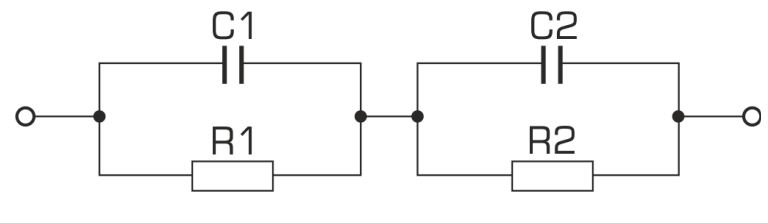
Figure 7. Electric equivalent RC system.